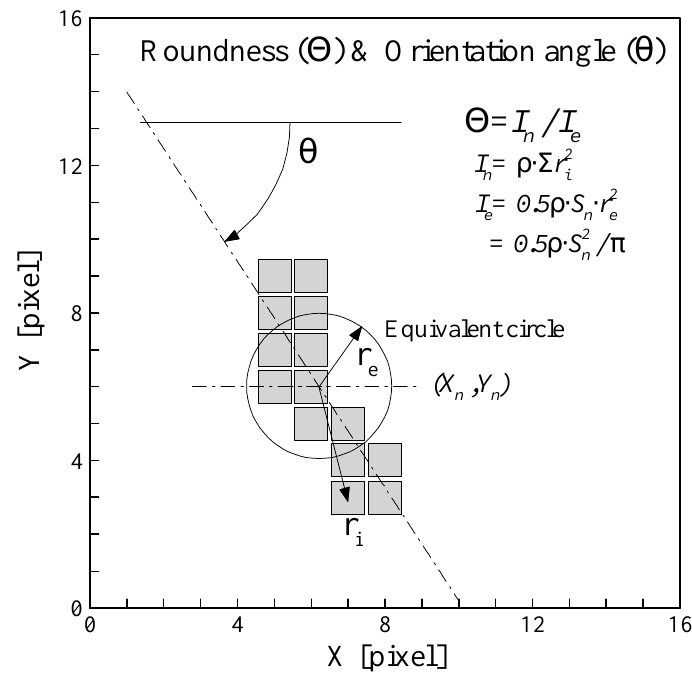
Figure 6. Roundness and orientation angle of ant